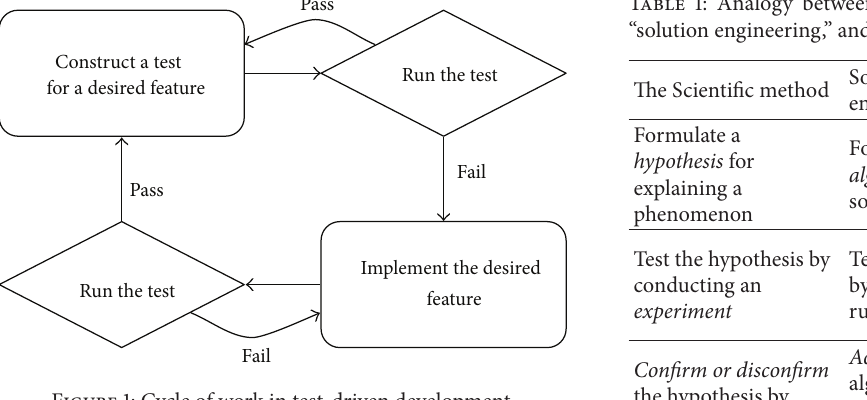
Figure 1: Cycle of work in test-driven development.